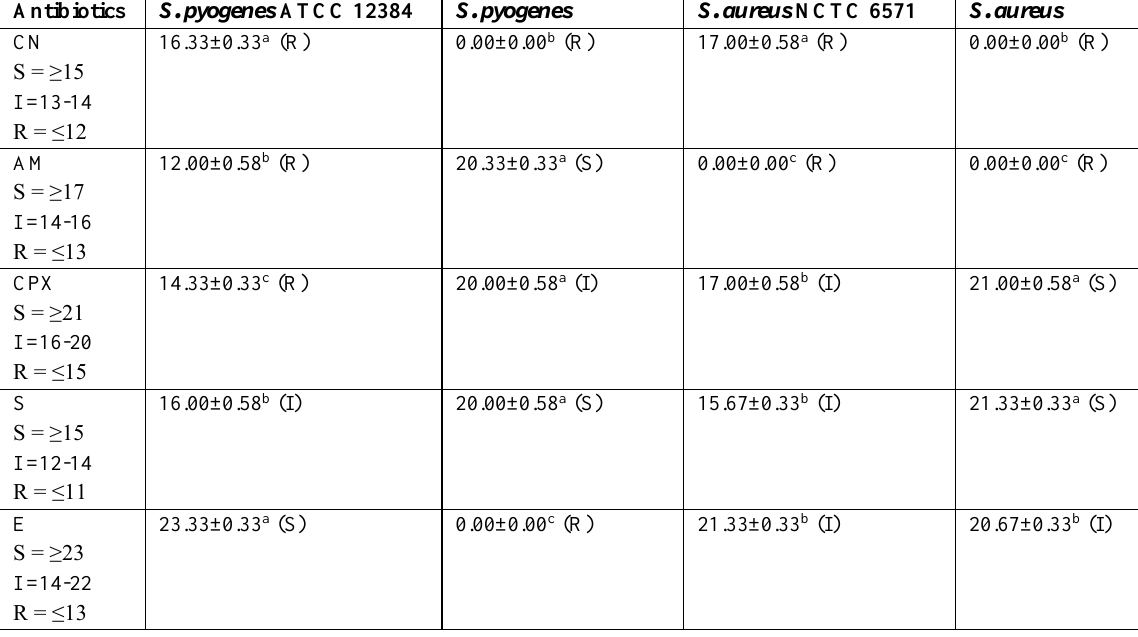
Table 2a. Comparative antibacterial activities of some conventional antibiotics on Gram positive clinical and typed isolates involved in throat